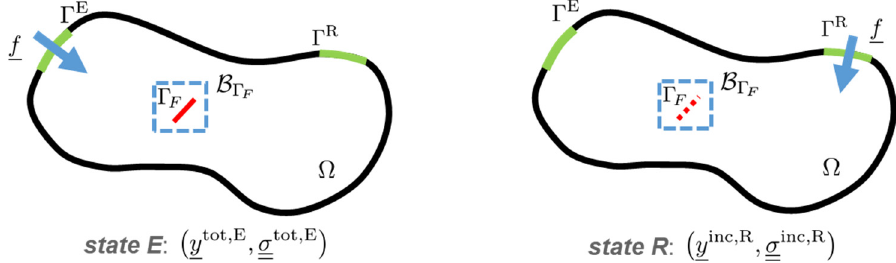
Figure A1. The two different states for reciprocity application. For state R, the dashed red line mimics the absence of the flaw.